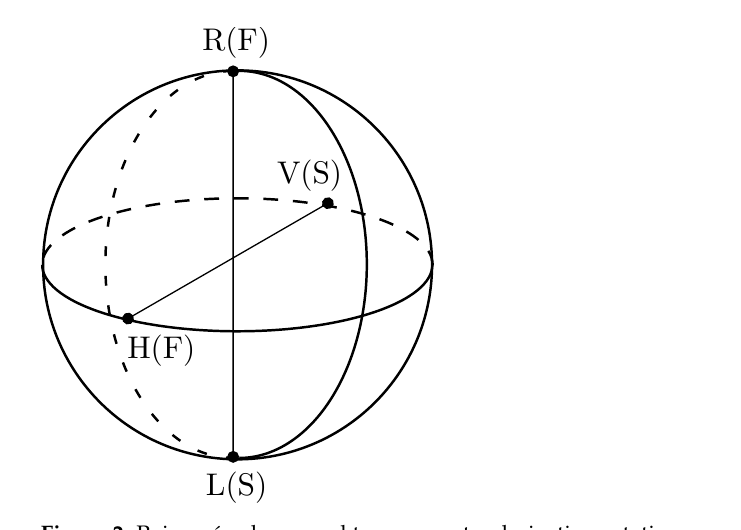
Figure 2. Poincaré sphere used to represent polarization